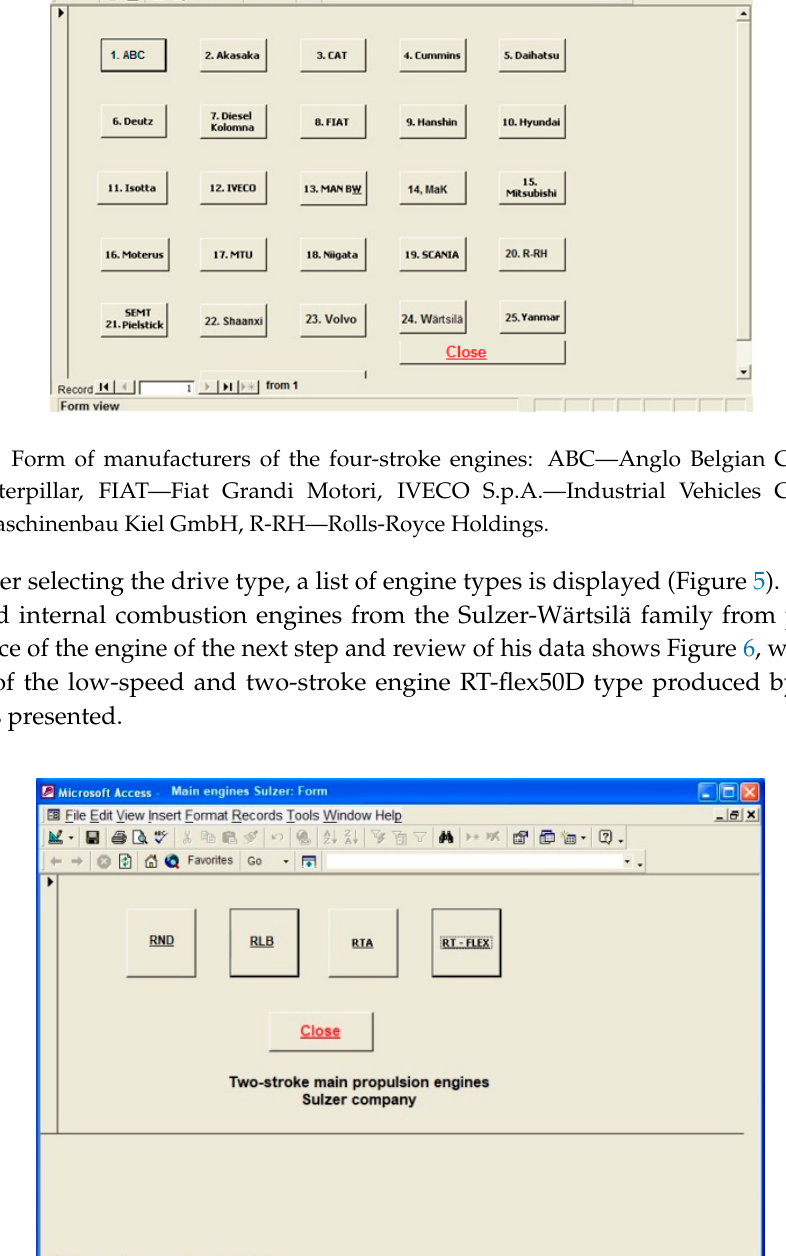
Figure 5. Types of the low speed main propulsion engines of sample producer.